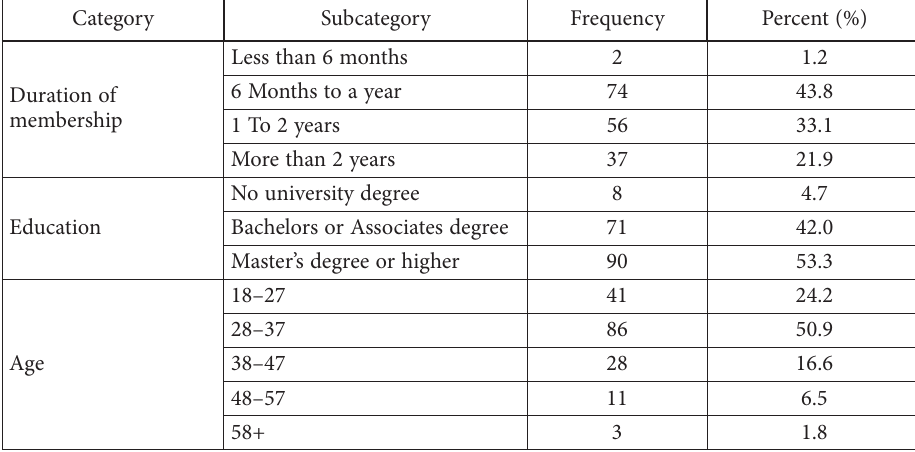
Table 3. Demographic breakdown of survey